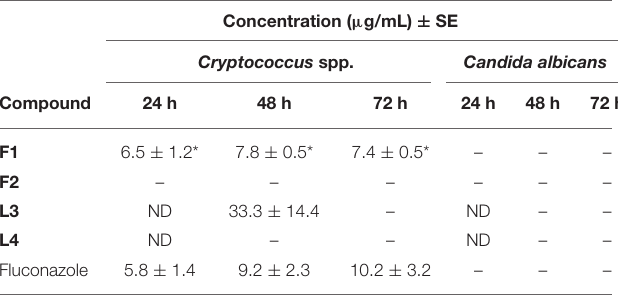
TABLE 5 | Minimal inhibition concentration ( µ g/mL) of tested compounds.